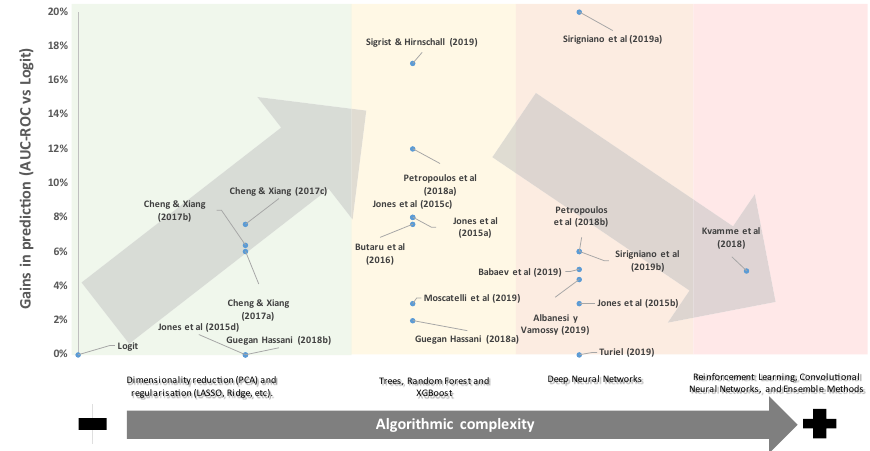
Fig. 1 The dilemma between prediction gains and algorithmic